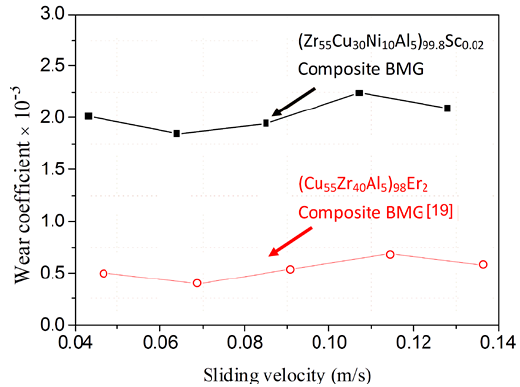
Figure 9. A plot of wear coe ffi cient versus sliding velocity for the Sc-bearing Zr-based composite